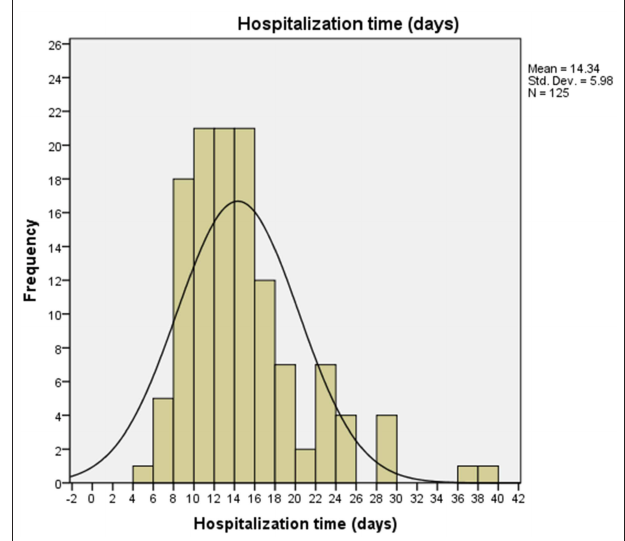
FIGURE 1 | Distribution of hospitalization time of 125 patients with COVID-19. The median hospitalization time was 13.0 days (IQR 10.0–17.0), ranging from 5.0 to 39.0